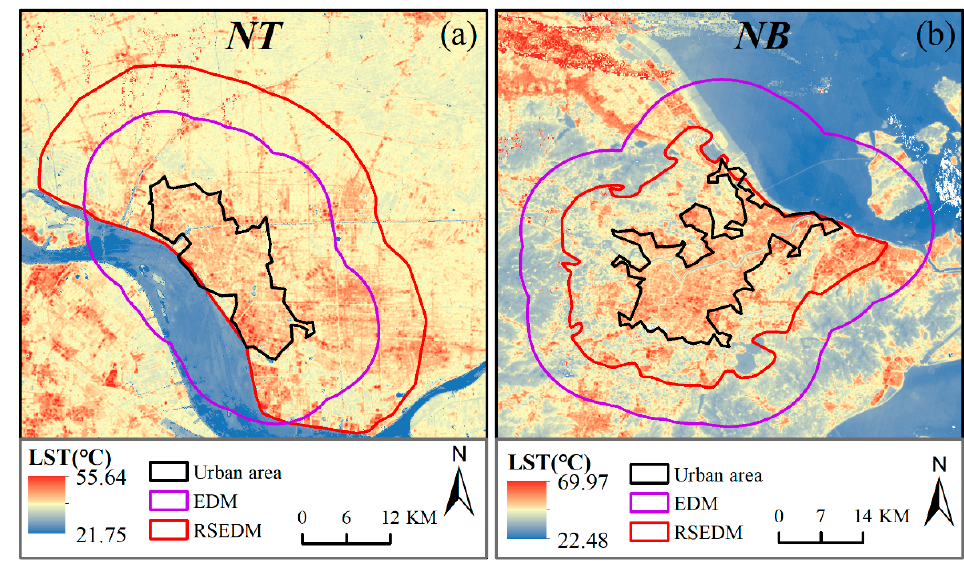
Figure 6. Footprint calculated by the rotational-scan exponential decay model and exponential decay model. ( a ) Nantong; ( b ) Ningbo.